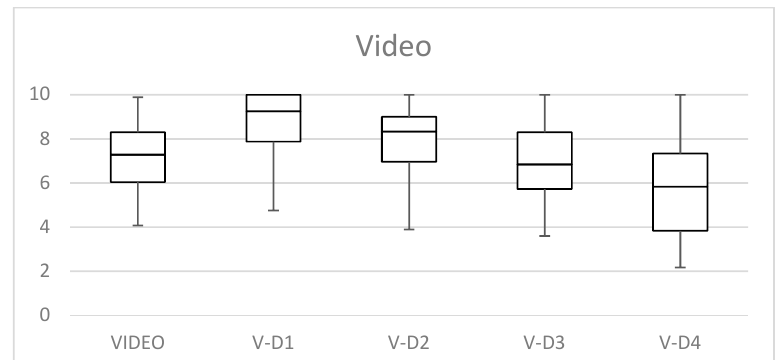
Figure 2. Box diagram showing the distribution of scores for the videos and scores for each of the 4 dimensions used to evaluate the videos (V-D1, V-D2, V-D3, and V-D4). The horizontal line within each box represents the median. The lower and upper limits of each box correspond to the 25th and 75th percentiles, and the lower and upper ends of the vertical lines refer to the outliers. Table 5. Average scores and standard deviations for items I-11 to I-26 from dimensions V-D3 and V-D4. The average scores that fall above 0.9 or below 0.4 are shown in bold